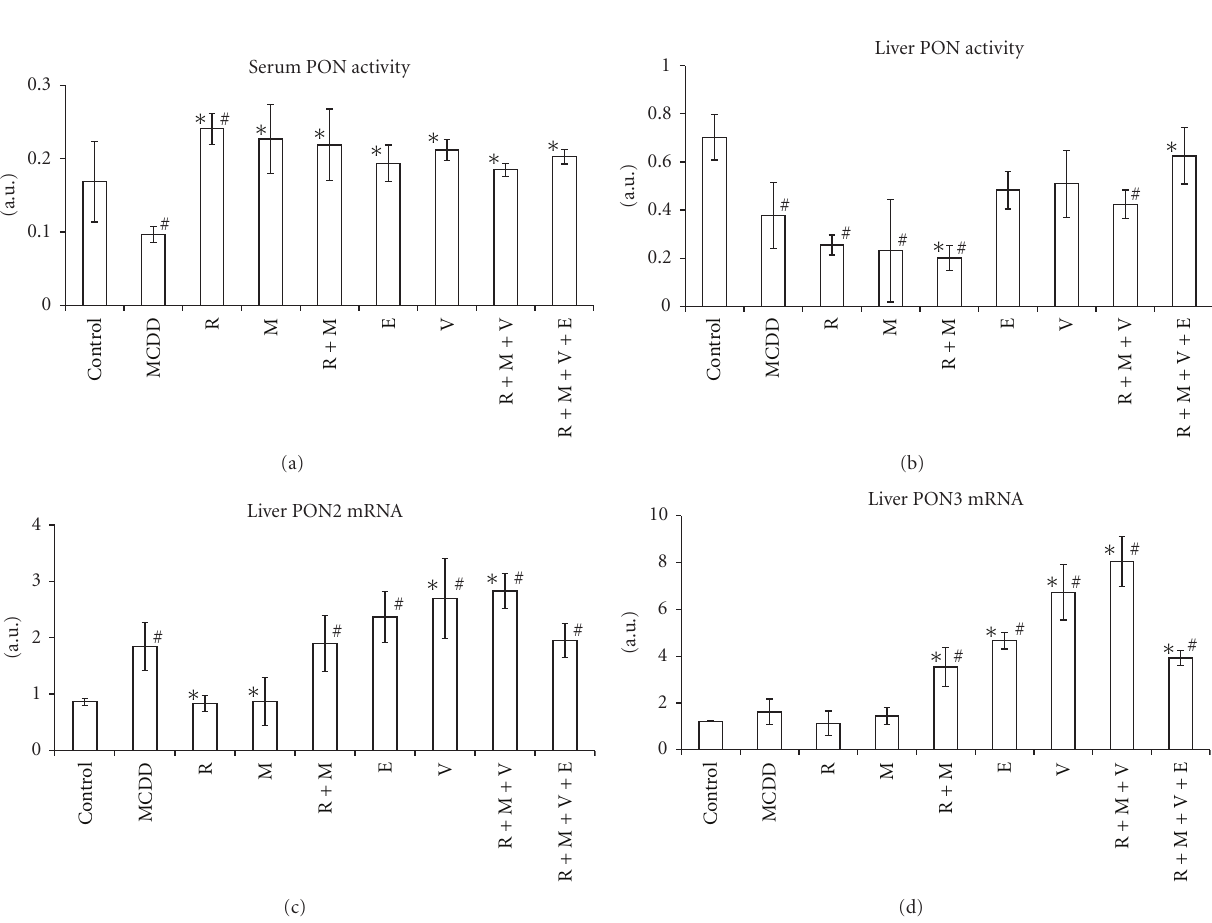
PON3 mRNA expression increased significantly ( P < 0 . 001) in the groups ezetimibe, valsartan,